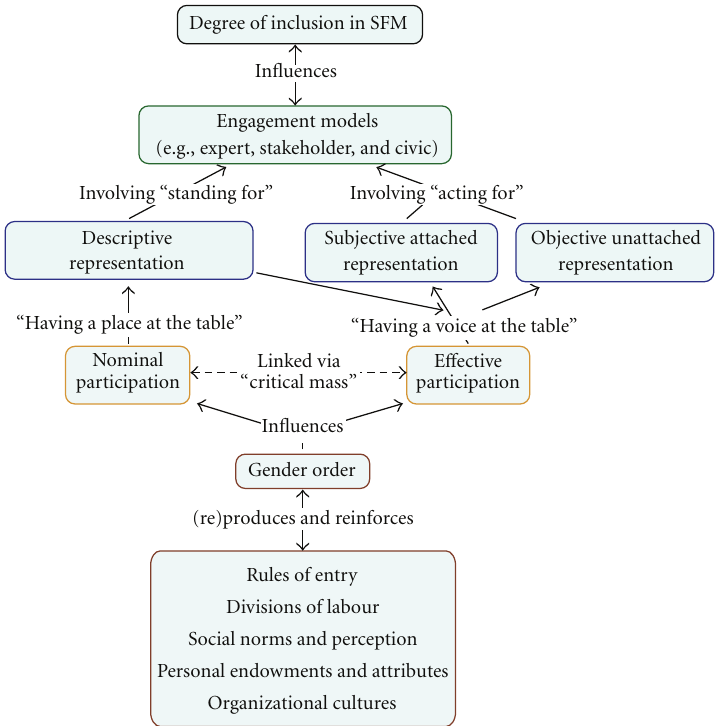
Figure 2: Concept map highlighting framework for considering gender order in